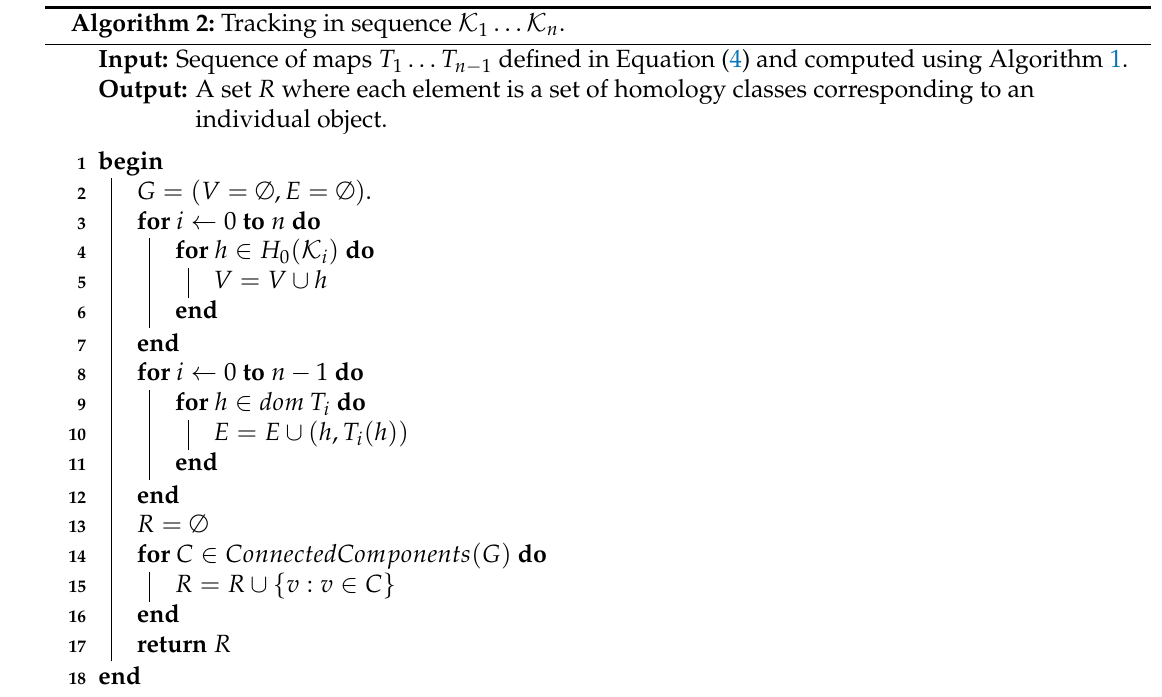
Algorithm 2: Tracking in sequence K 1 . . . K n